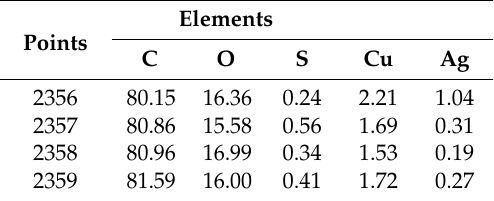
Table 1. SEM-EDS elemental composition of the elements present in the analyzed points. Elements Points C O